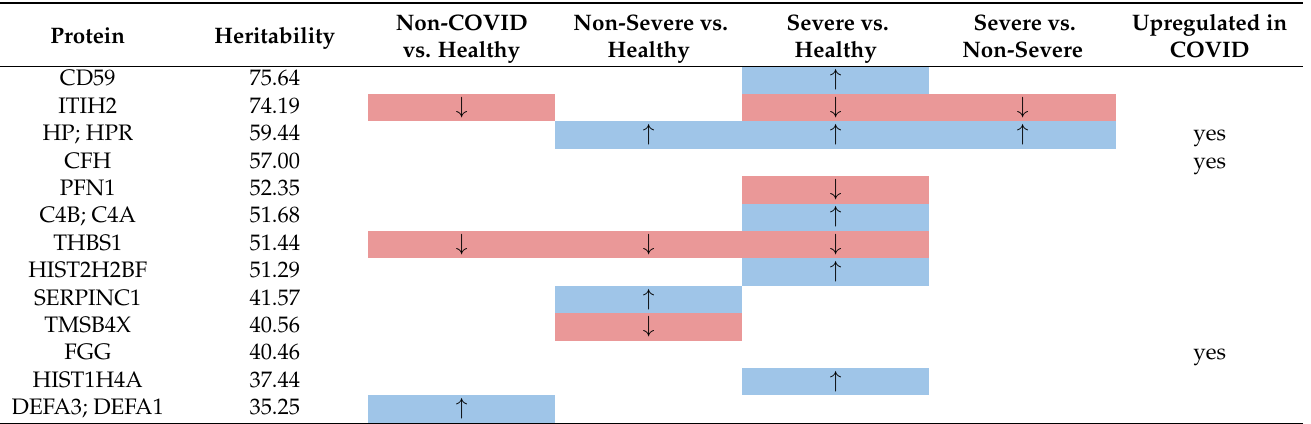
3.2. Proteins Associated with COVID-19 Disease States Are Highly Correlated in Erythrocytes To determine the relationships among proteins associated with COVID-19 disease states, we performed a Pearson correlation analysis using the erythrocyte protein expres- sion data. For this analysis, we combined all proteins either up- or downregulated in COVID-19 disease states from both [8,9], regardless of their heritability in erythrocytes, and excluded proteins that are differentially expressed only in non-COVID disease states. Of the 14 upregulated proteins, 5.5% of the correlations had a Pearson correlation ≥ 75% (Figure 1), and of the 17 downregulated proteins, 11.8% of the correlations were ≥ 75% (Figure 2). The same analysis performed for the four metabolites upregulated in COVID-19 showed that none had correlations ≥ 75%, and for the 51 downregulated metabolites only 0.9% of the correlations were ≥ 75% (Supplemental Figures S1 and